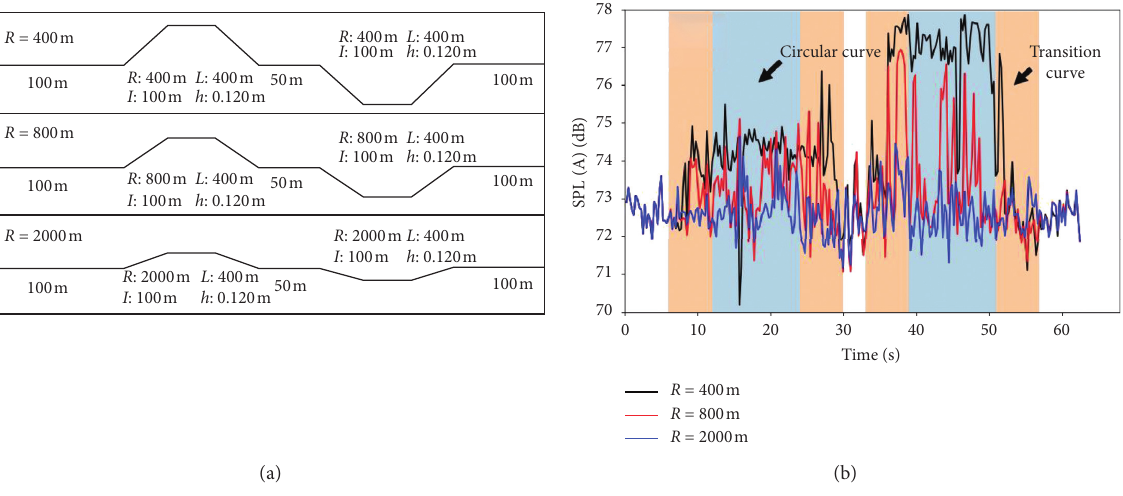
Figure 8: Evaluation of railway alignments considering interior